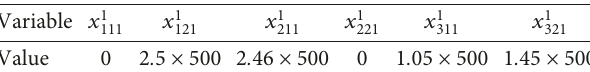
Table 12: The amounts of transported goods stored at all sup- plementary origins. Table 13: The quantity of goods transported to final destinations D1 and D2.